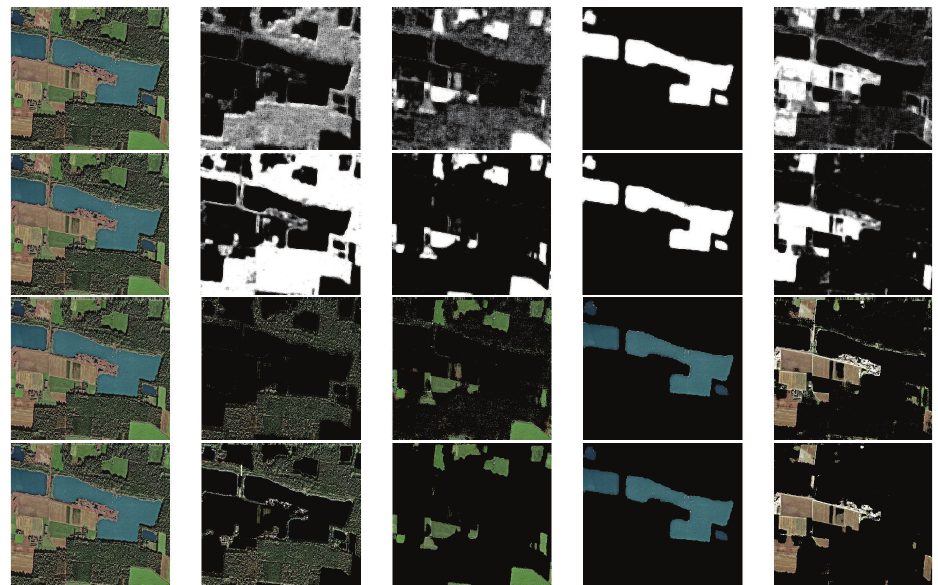
Figure 7: Natural image segmentation after thresholding. Line 1: membership functions using Shen’s model. Line 2: membership functions using the proposed model. Line 3: hard segmentations using Shen’s model. Line 4: hard segmentations using the proposed